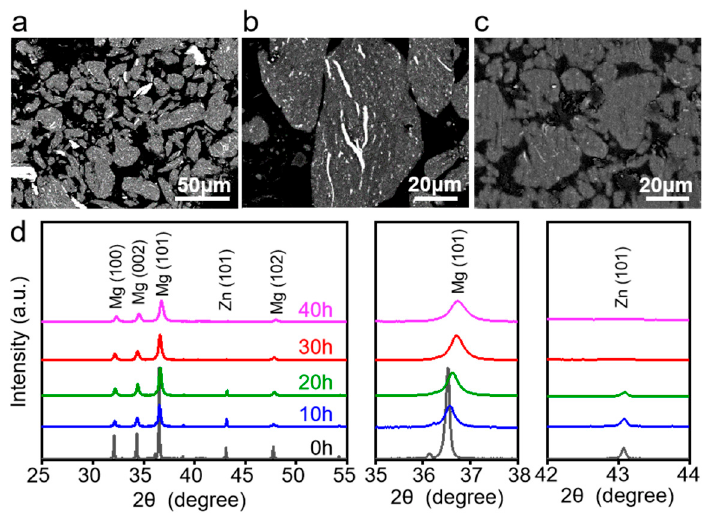
Figure 3. SEM image showing the cross-sections of Mg-Zn powders after milling for ( a ) 10 h, ( b ) 20 h, and ( c ) 30 h. ( d ) XRD patterns of as-milled powders.